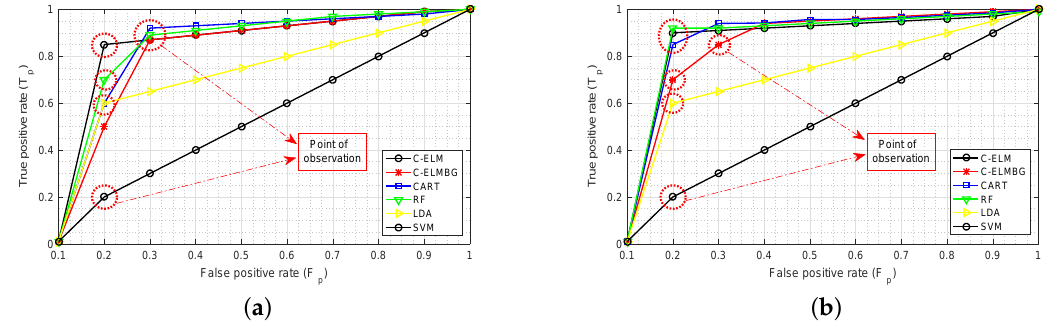
Figure 6. Receiver operating characteristic (ROC) curves: ( a ) test set corresponding to Training Set 1 for different classifiers; ( b ) test set corresponding to Training Set 2 for different